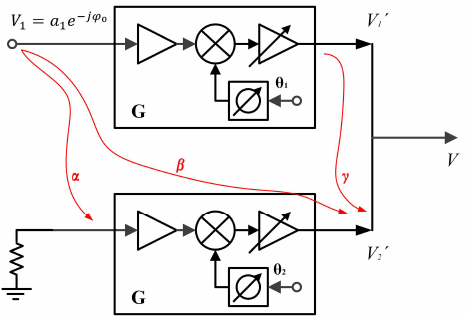
Figure 12. Path analysis of channel mutual coupling.